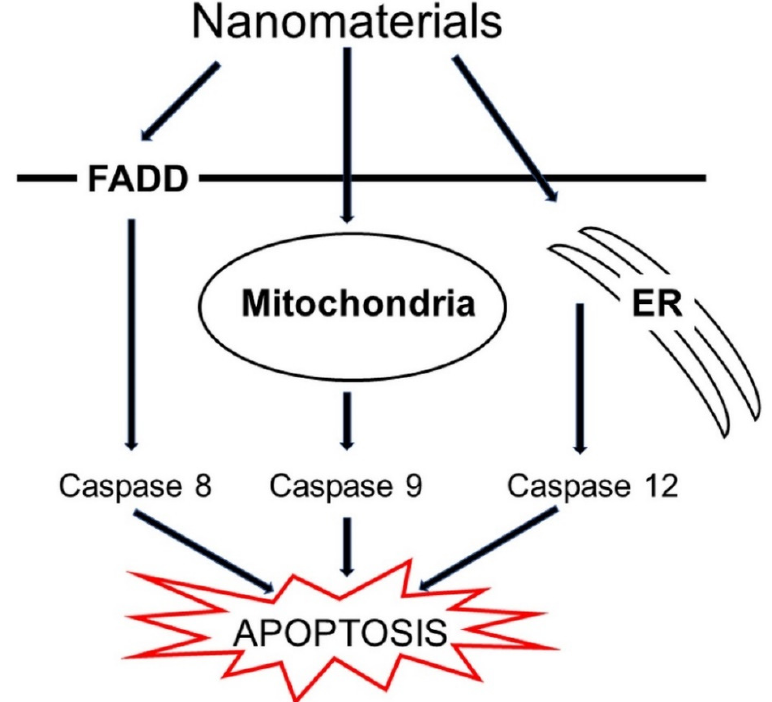
Figure 6. Possible pathways of induction of apoptosis by nanomaterials in cells. Abbreviations: ER = endoplasmatic reticulum and FADD = FAS-associated death domain protein.